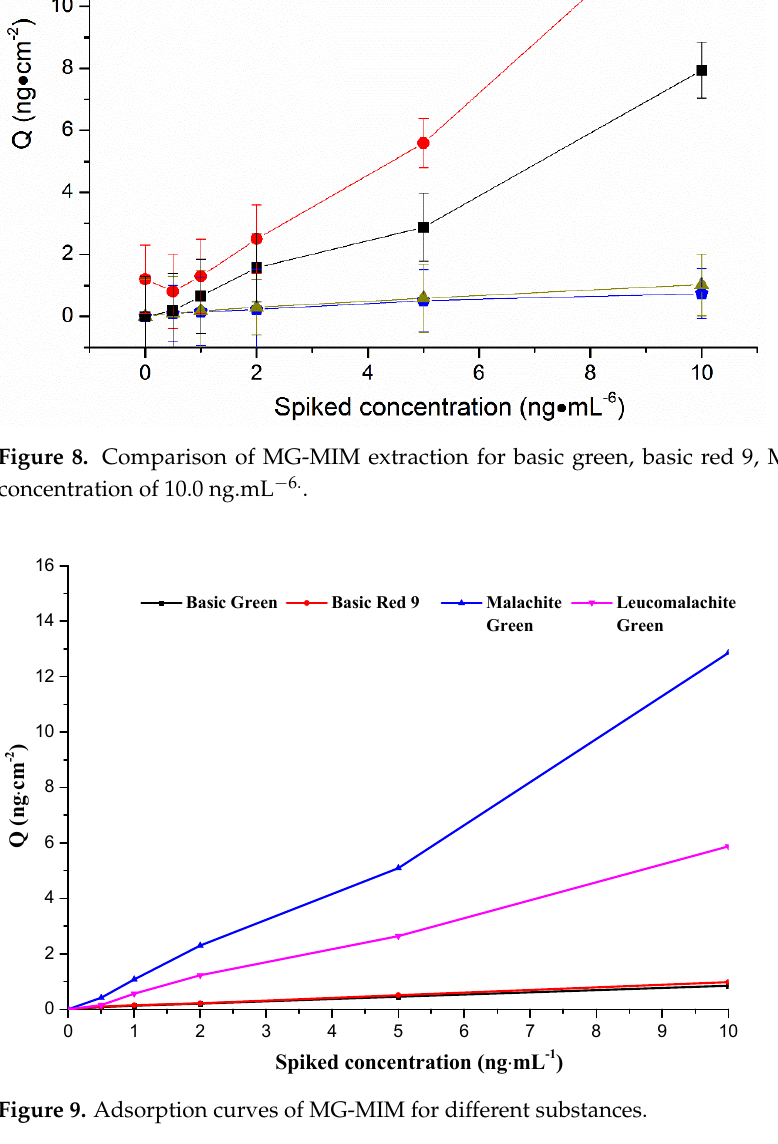
Figure 8. Comparison of MG ‐ MIM extraction for basic green , basic red 9, MG and LMG at the concentration of 10.0 ng.mL − 6.